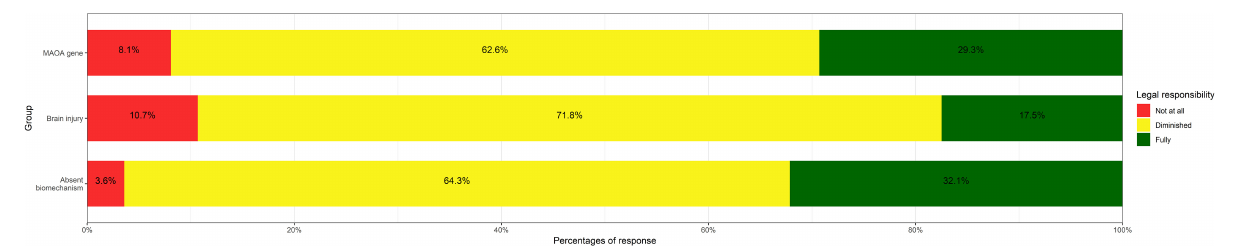
FIGURE 4 | Plot of proportional cross-tables (contingency tables) showing the response to the question how legally responsible the offender is.